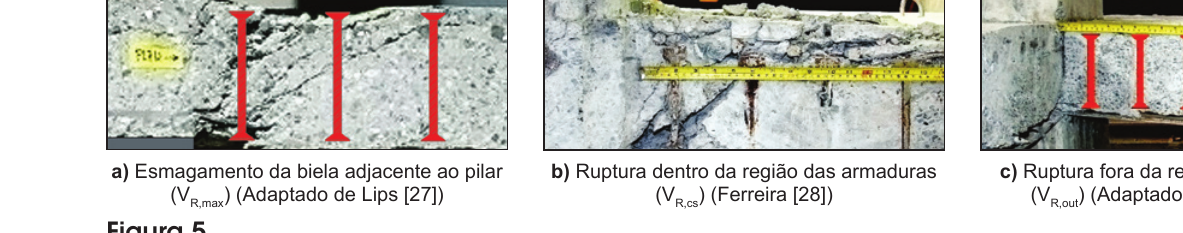
Modos de ruptura por punção em lajes armadas ao